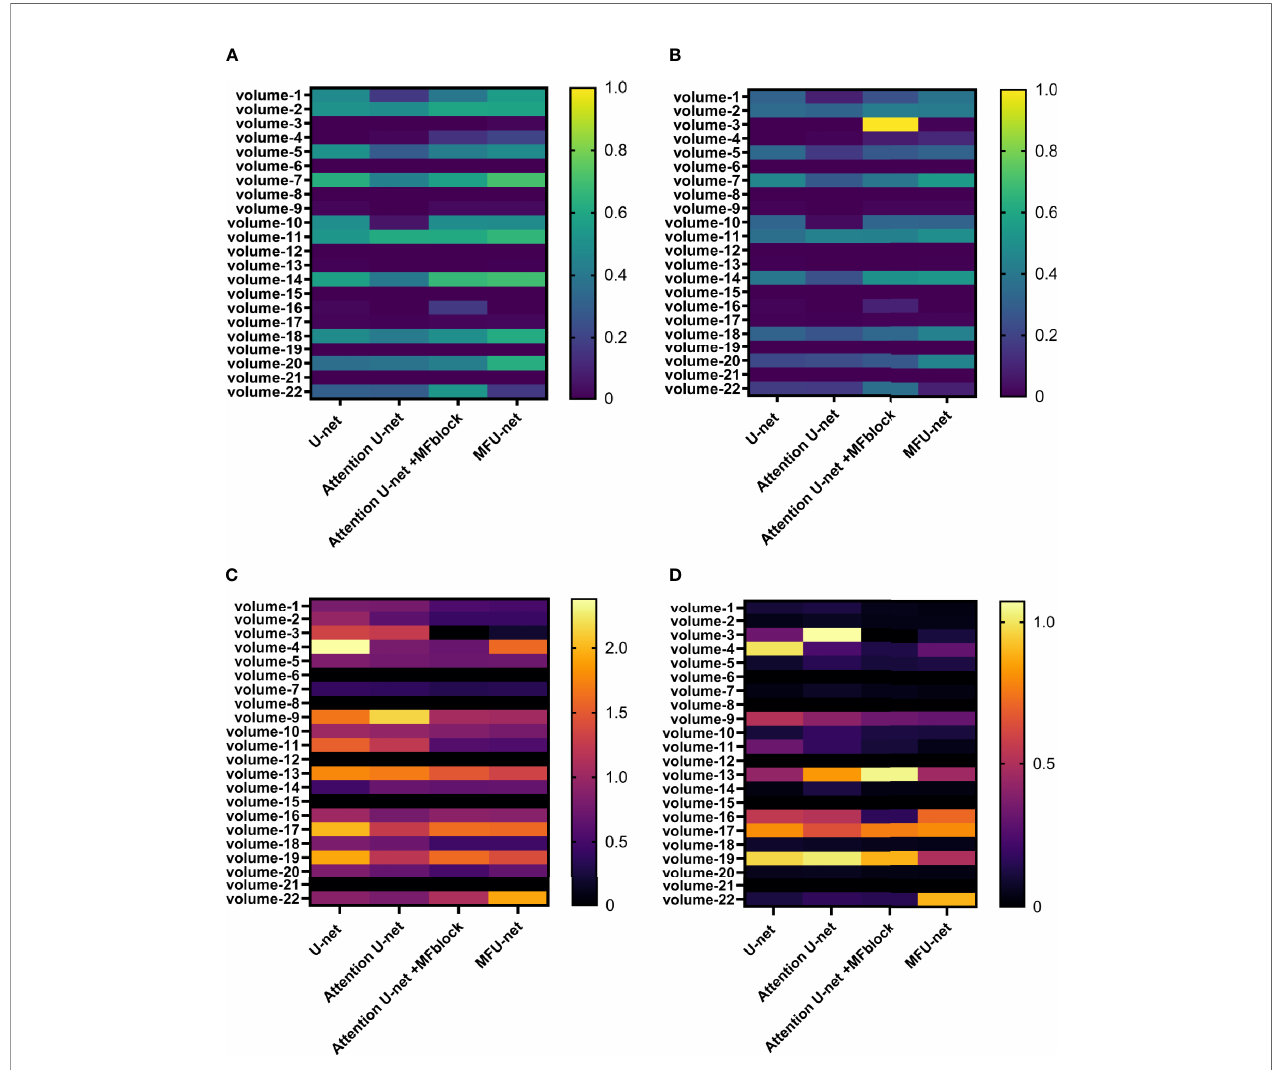
FIGURE 7 | Performance on 3Dircadb dataset via four metrics: (A) dice score, (B) Jaccard score, (C) MSSD score, and (D) ASSD score.